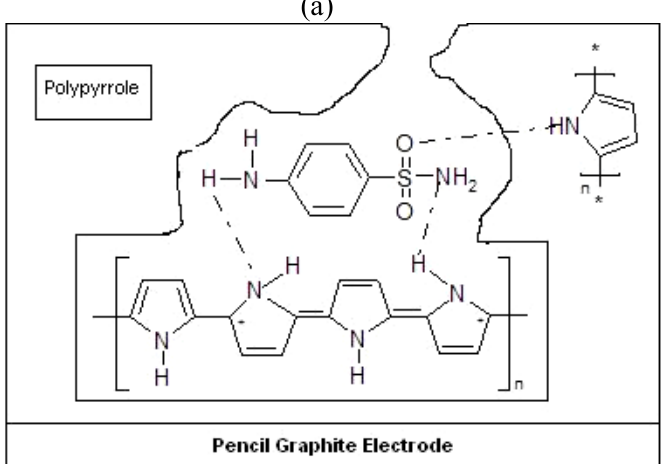
Figure 3. Schematic representation of (a) imprinting and (b) removal of sulfamethoxazole from sulfamethoxazole imprinted polypyrrole modified pencil graphite